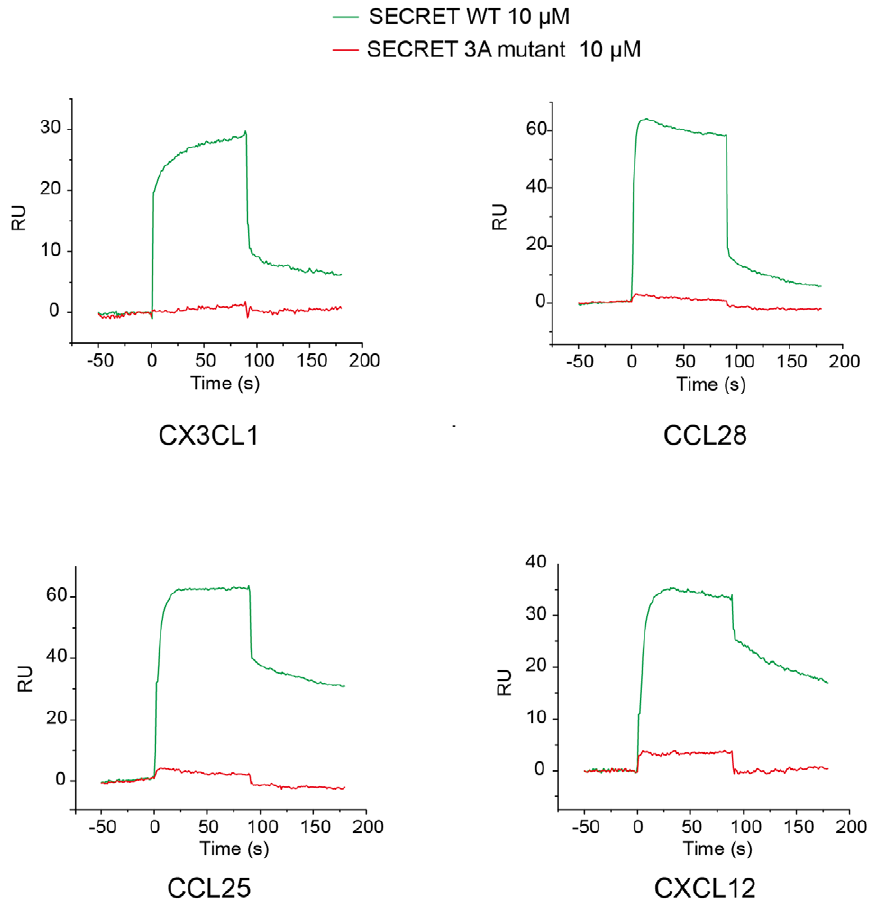
Figure 7. Sensograms of passing the SECRET domain wild type (green) and D167A/E169A/D316A mutant (red) through the CM5 chip surface immobilized with chemokines CX3CL1, CCL28, CCL25, and CXCL12, respectively. The D167A/E169A/D316A mutant is referred as 3A mutant in the figure.